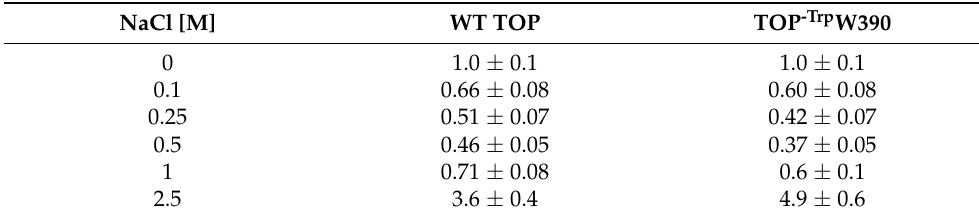
Table 3. Catalytic efficiencies ( k cat / K M ) for the hydrolysis of substrate QFS by TOP WT and TOP F390W at different concentrations of NaCl.